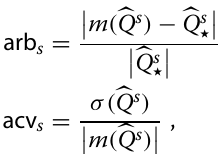
variance than fixed lag estimates with negligible bias (i.e., in this case, lags larger than 10). Small lags lead to strongly biased estimates for the fixed-lag method, and unbiased estimates are at the cost of a large variance. It is worth noting here that the lag for which the bias is small is model